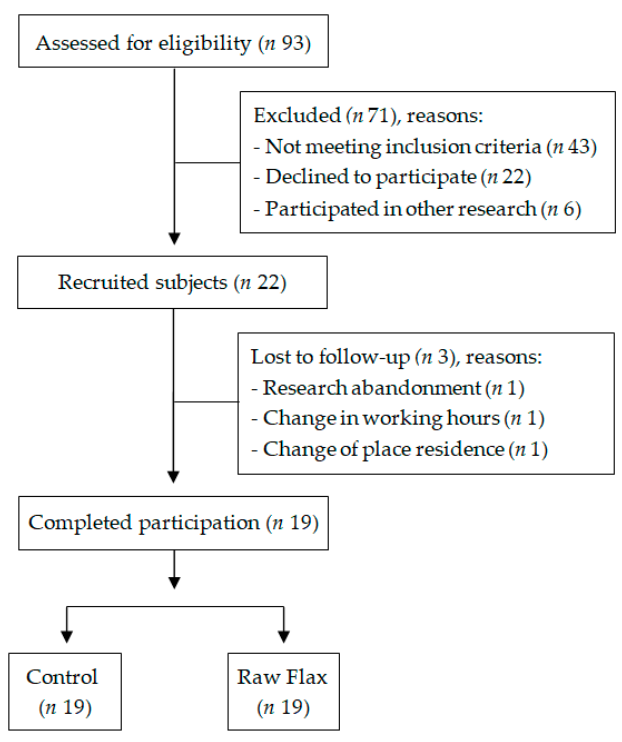
Figure 1. Study participants’ flowchart ( n = 19).